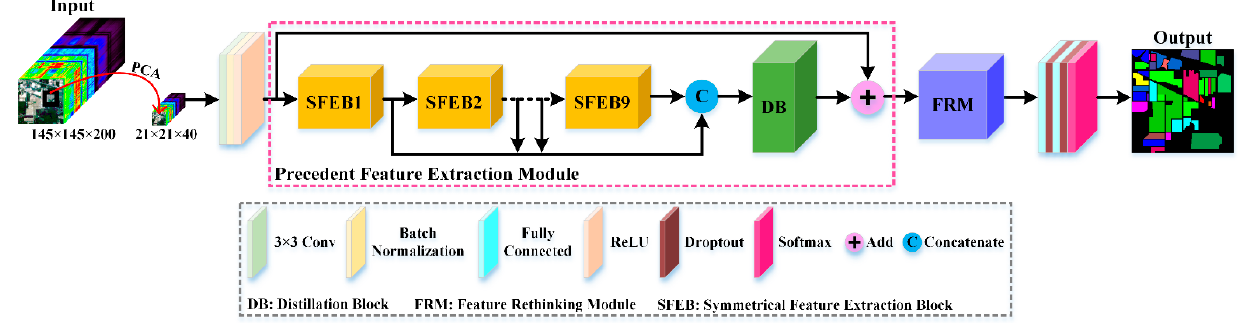
Figure 1. Overview of the presented HS 2 FNet for HSI classification.